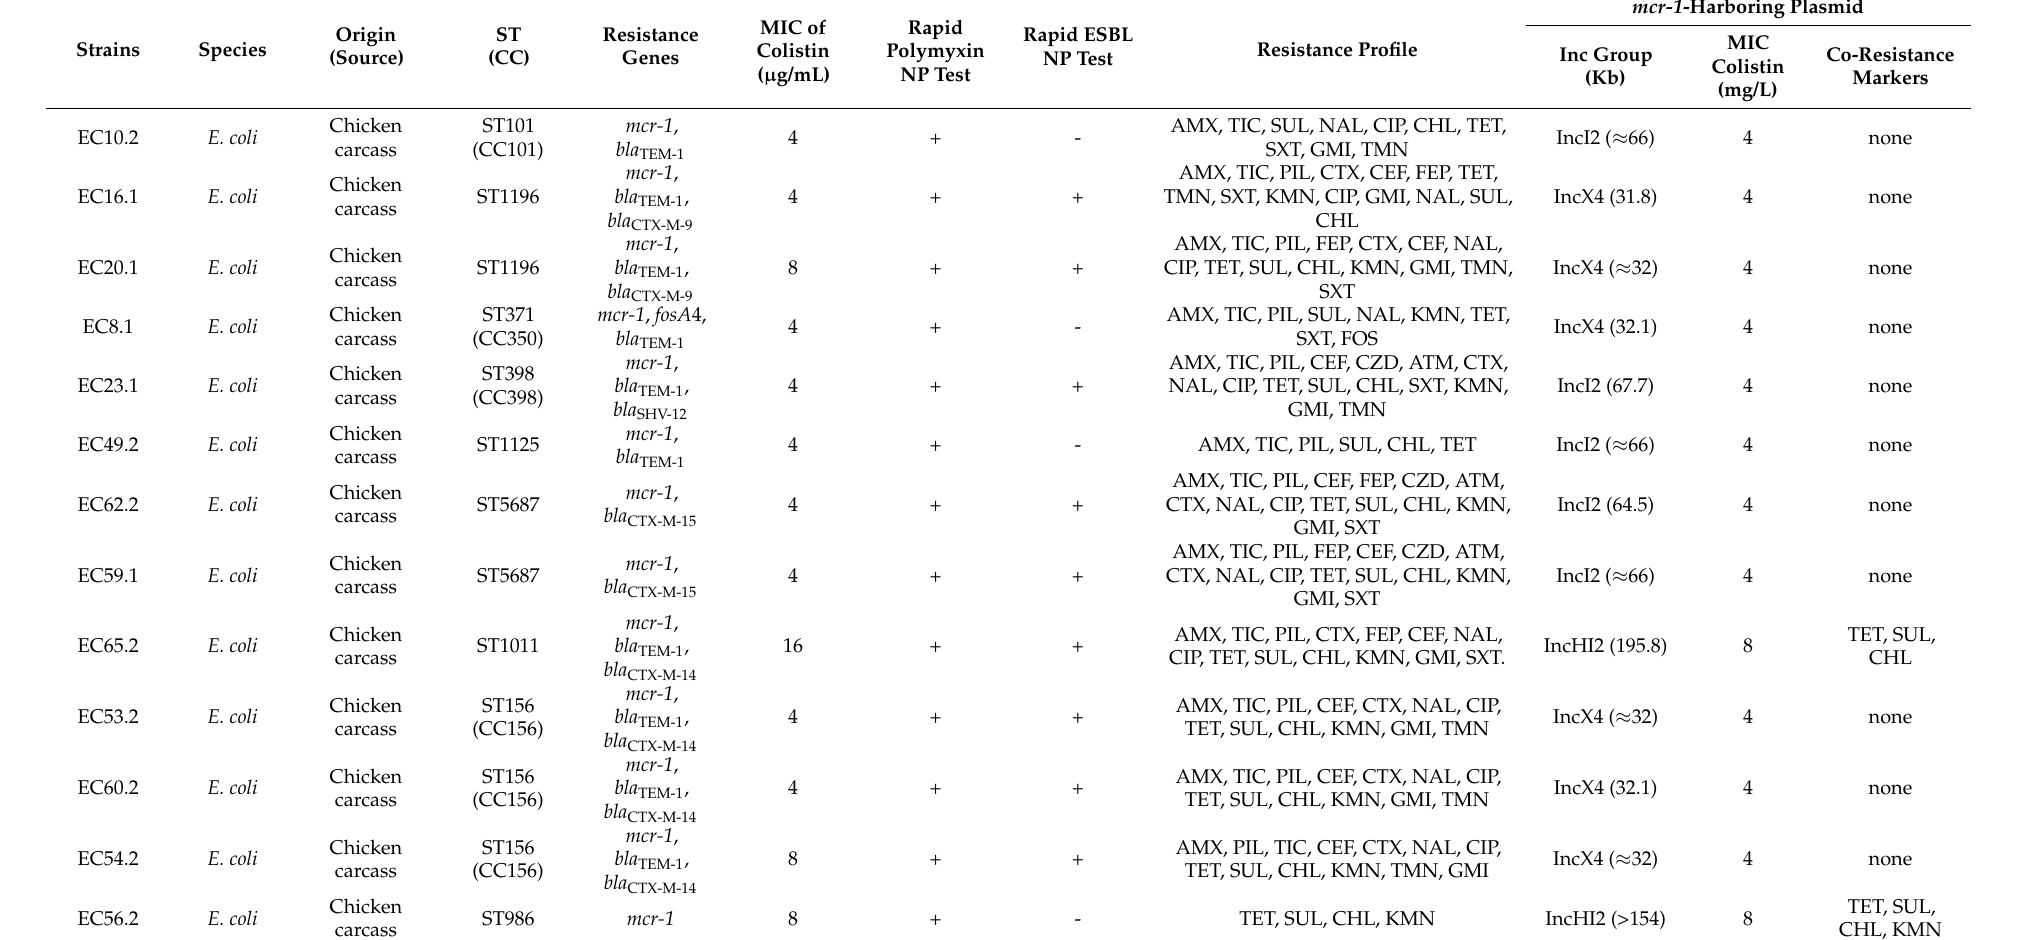
Table 1. Phenotypic and genetic features associated with MCR-1-producing E. coli isolates from chicken carcasses,